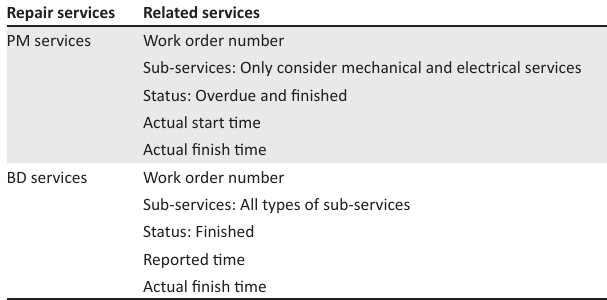
TABLE 1: Related categories for analysis. Repair services